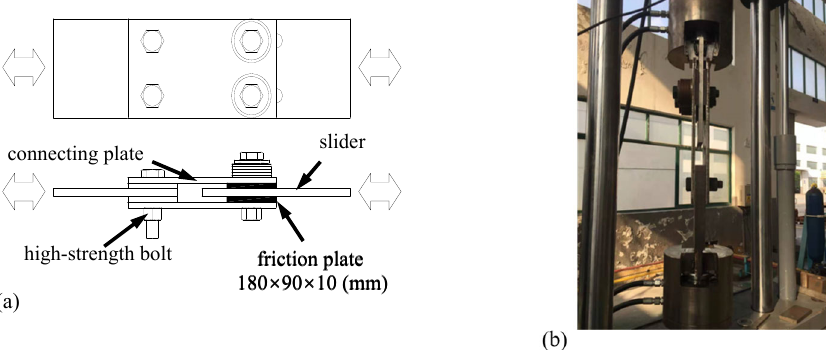
Figure 6. Material ‐ property test: ( a ) schematic of the test specimen; and ( b ) on ‐ site loading test. Table 1. Detailed information of the material test.